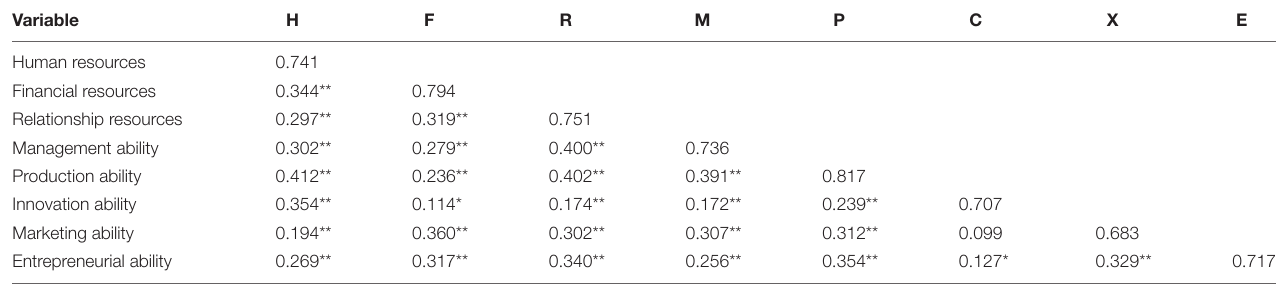
TABLE 3 | Correlation analysis of competitive